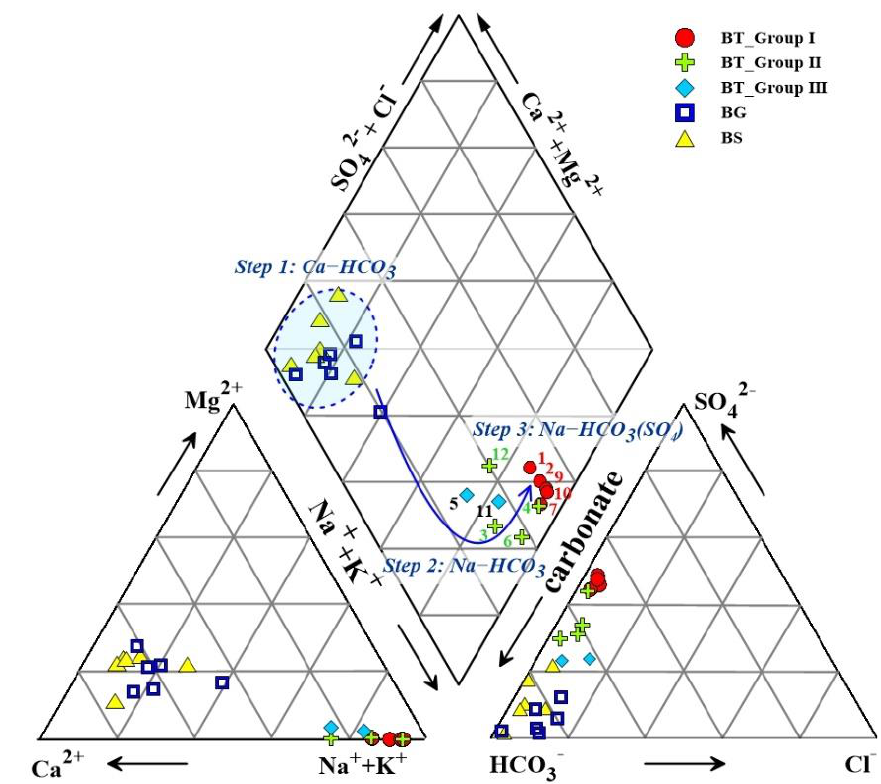
Figure 4. The trilinear plot of the major chemical compositions of thermal waters, groundwater, and stream waters (scale of diagram is expressed as the relative concentration percentage of ions in milli-equivalent unit). The δ 18 O and δ D data from all the samples are presented in Tables 1 and 2. Group I and II thermal water is plotted above or on the Global Meteoric Water Line (GMWL) [41] reflecting deuterium enrichment. Groundwater, stream water, and Group III thermal water are plotted between the GMWL and the Local Meteoric Water Line (LMWL) [42] in Figure 5. It was reported that the isotopic fractionation of thermal water in the deep environment after the recharge of meteoric water caused deuterium enrichment through H 2 S exchange as follows [43,44]: